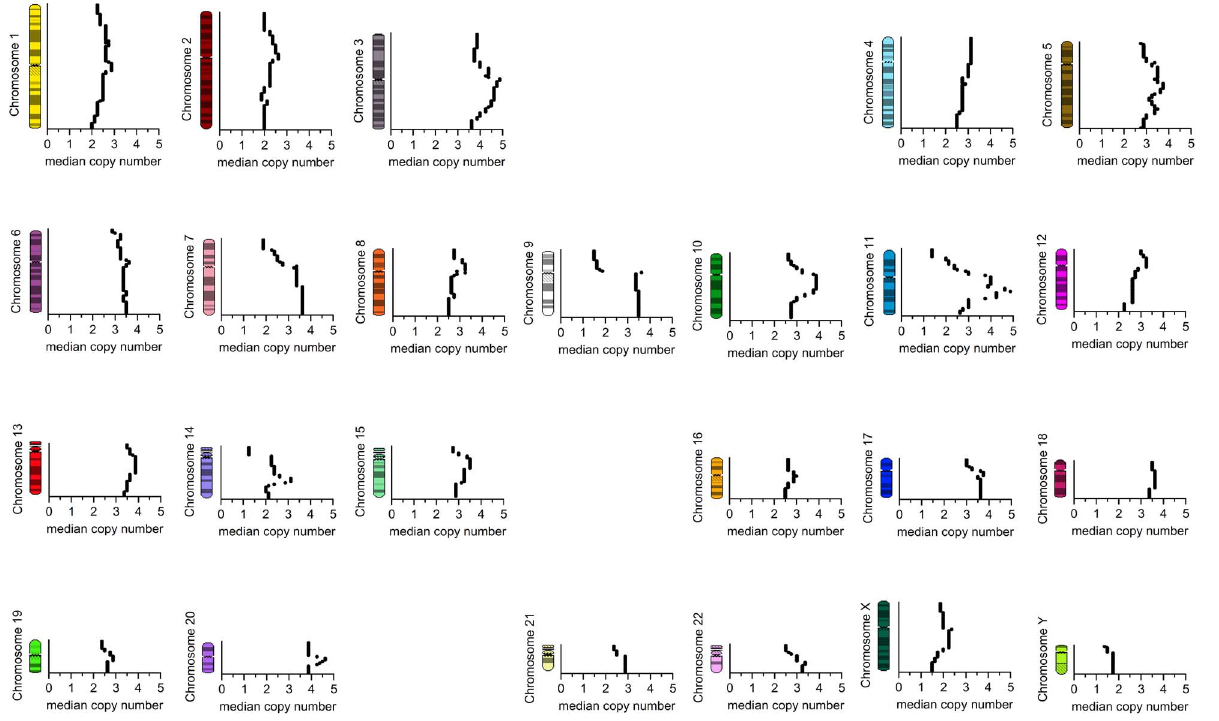
Figure 4. Median appearance of chromosome regions per cell based upon SKY analysis of eight metaphases from human LX-2 cell line. The average copy numbers per cell of each human chromosome region are shown in correspondence to their chromosome ideogram based on summary SKY analysis.